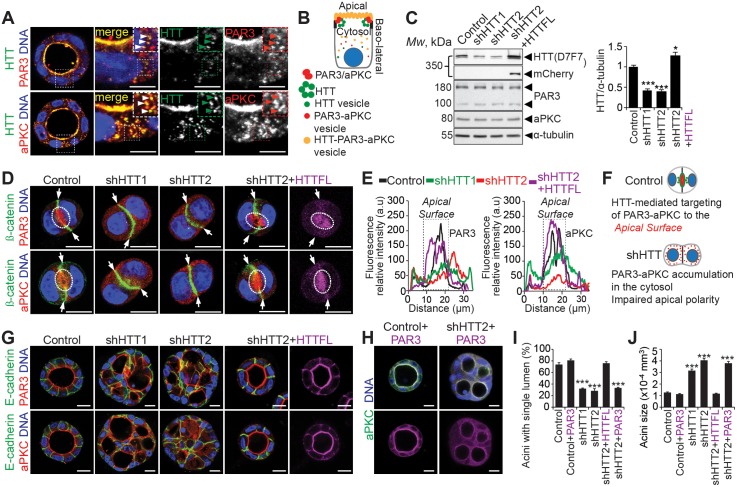
HTT regulates apical vesicular trafficking of PAR3-aPKC during cystogenesis.(A) Four-day MDCK 3-D cultures stained for HTT 4C8 and PAR3 or aPKC. Arrowheads indicate localization of HTT and PAR3 or aPKC to vesicular-like structures. Colocalization of HTT and PAR3 or aPKC is displayed in yellow (merge). (B) Illustration showing the HTT/PAR3/PAR6/aPKC complex localization on apical membrane and vesicles. (C) Western blotting of MDCK cell extracts. The histogram corresponds to the quantification of HTT levels. (D) 24 h MDCK 3-D structures stained for ß-catenin and PAR3 or aPKC. HTTFL is tagged with mCherry and staining is displayed in magenta. Arrows indicate the basolateral compartment and dashed ellipses indicate the apical surface. (E) Representative line-scan analysis (relative fluorescence intensity; at least 20 cells were analyzed per condition). (F) Illustration showing the role of HTT in PAR3-aPKC apical vesicular trafficking. (G) Four-day MDCK 3-D structures stained for E-cadherin and PAR3 or aPKC. (H) Four-day MDCK 3-D structures stained for aPKC. PAR3-GFP staining is displayed in magenta and the colocalization of aPKC and PAR3-GFP appears in white. (I) Percentage of acini with normal lumen. (J) Quantification of acini size. (I and J) Control: n = 125 acini, Control + PAR3: n = 102 acini, shHTT1: n = 149 acini, shHTT2: n = 114 acini, shHTT2 + HTT: n = 163 acini, shHTT2 + PAR3: n = 89 acini. All scale bars, 10 μm. Error bars, SEM. *** p<0.001. Complete statistical analyses with number of measures are detailed in S1 Data.